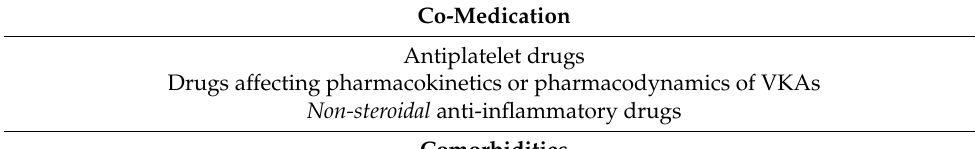
Table 1. Factors affecting the quality of vitamin K antagonist